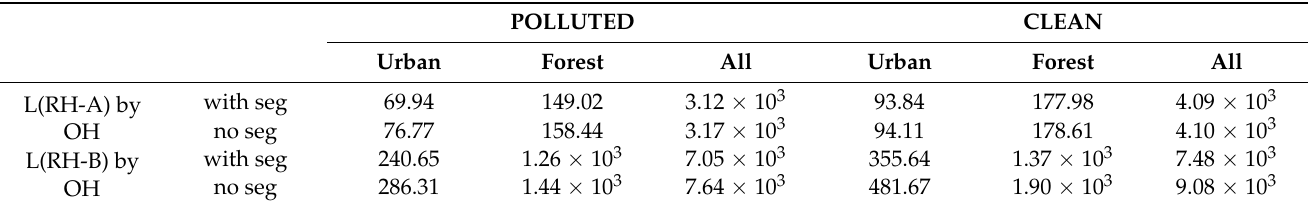
Table 2. Number of moles of RH-A/RH-B destroyed by OH integrated during a time period of 1 h over the lowest 20 model levels (below ~800 m) in the urban area, the forested area, and the entire domain, respectively. The results are provided for the POLLUTED and CLEAN cases. “seg” represents segregation. POLLUTED CLEAN Urban Forest All Urban Forest